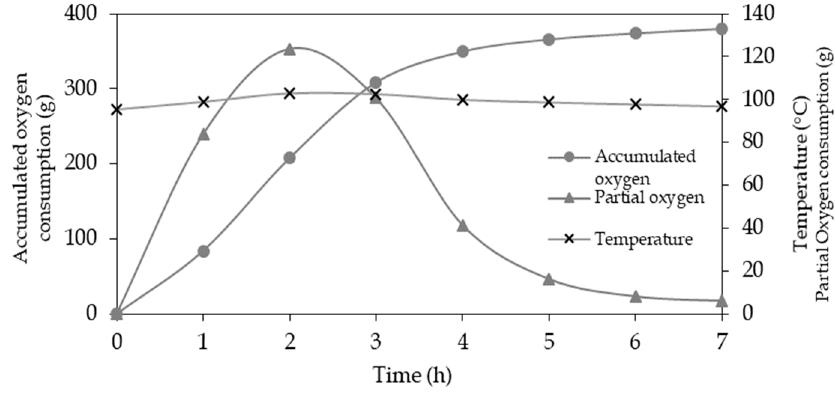
Figure 6. Temperature and partial and accumulative oxygen consumption over time in test P5.